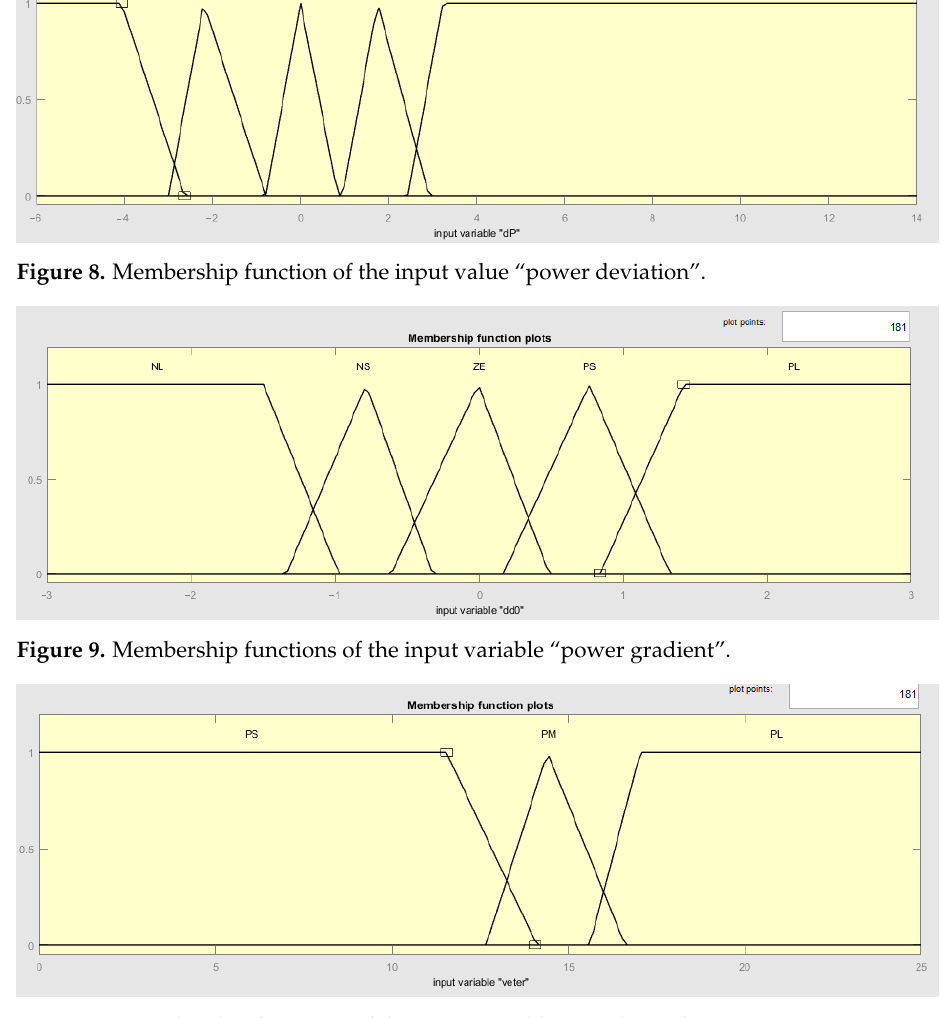
Figure 10. Membership functions of the input variable “wind